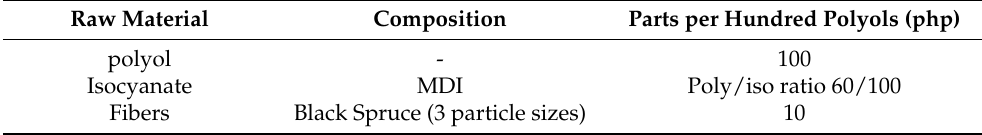
Table 2. Polyisocyanurate foam formulation.